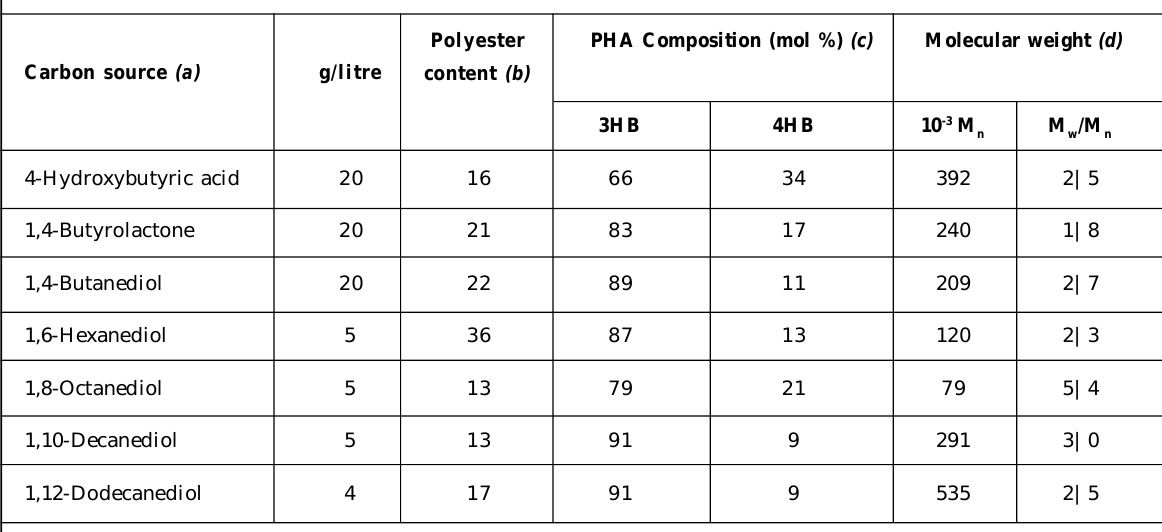
Table 2: Production of P(3HB-co-4HB) from carbon sources by Alcaligenes eutrophus . Adapted from Saito et al .,